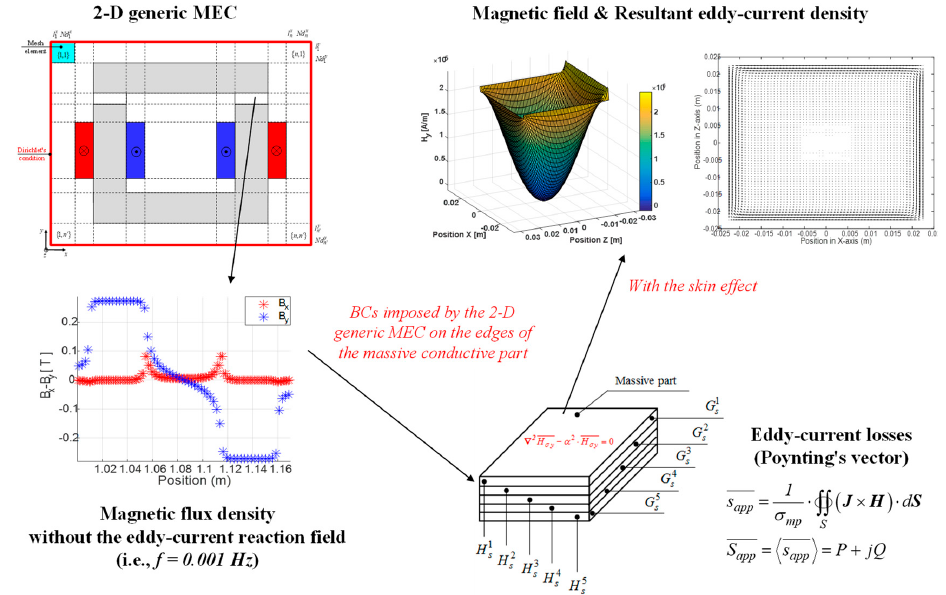
Figure 2. Principle of model coupling.